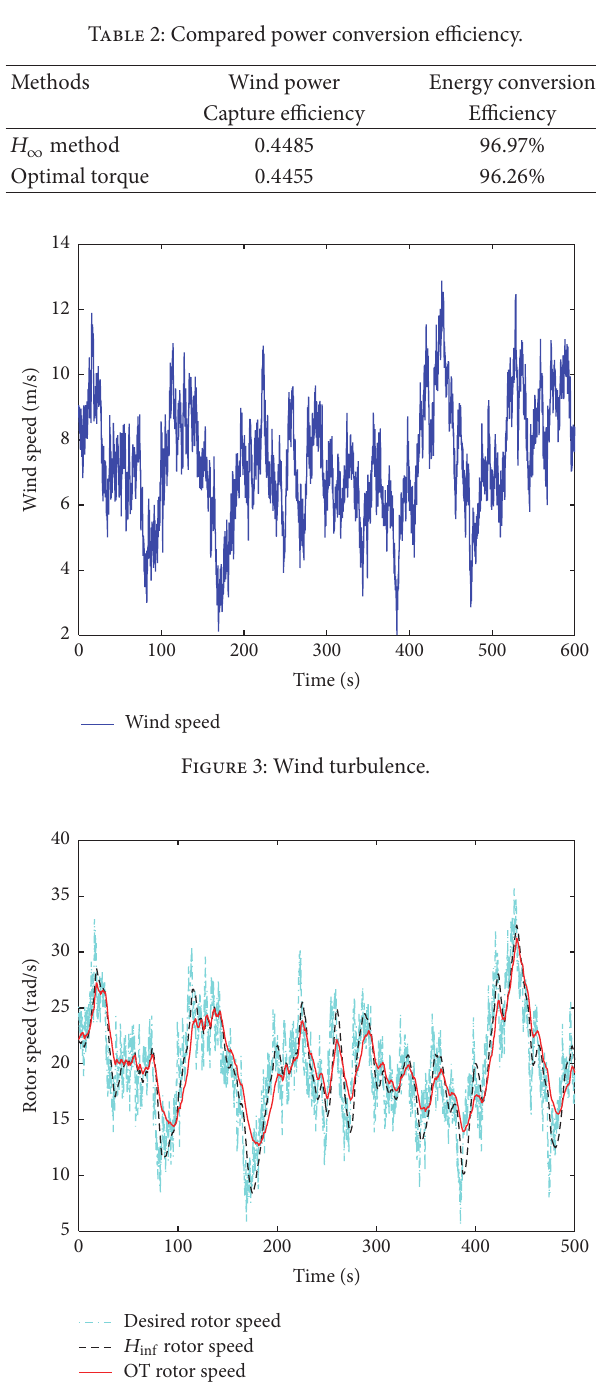
Figure 4: Controlled results by 𝐻 ∞ method and OT